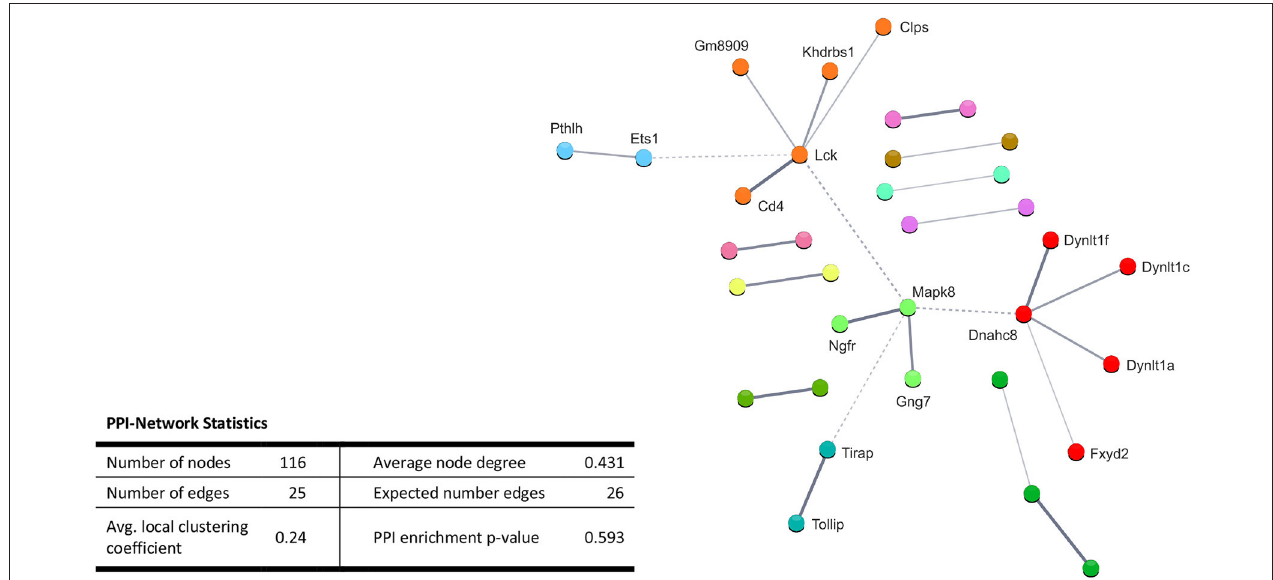
FIGURE 4 | STRING database protein-protein interaction (PPI) networks of significantly upregulated genes. Cut-off values, p ≤ 0.01, fold change ≥ 1.2. Cluster analysis did not reveal any protein-protein interaction clusters.